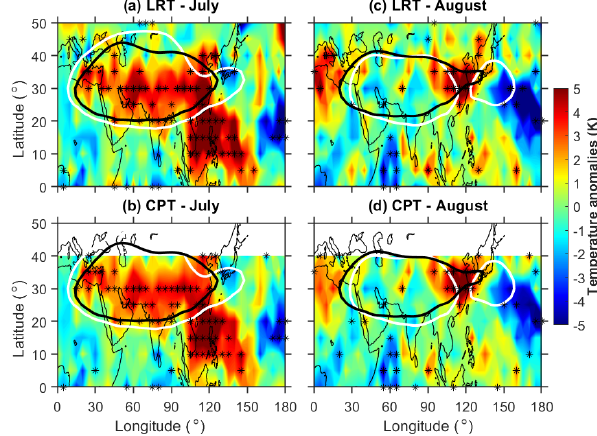
Figure 10. Spatial distribution of (a) lapse rate tropopause tem- perature (LRT) and (b) cold-point tropopause temperature (CPT) anomalies during July 2015. Subplots of (c) and (d) same as (a) and (b) but for the month of August 2015. The white (black) color contour represents the 16.75km geopotential height at 100hPa for the corresponding month in 2015 (mean of 2005–2014). The star symbols (black) shown in the figure represent the anomalies greater than the ± 2 σ standard deviation of the long-term